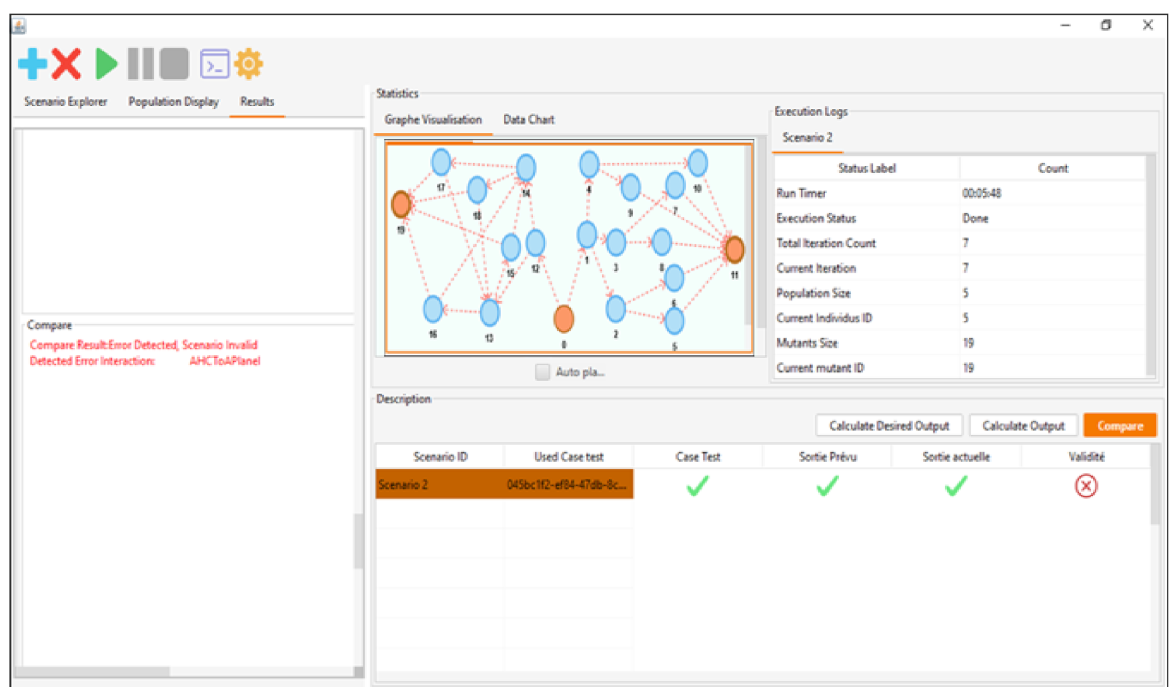
Figure 7. End of the test of scenario 1 (no errors).